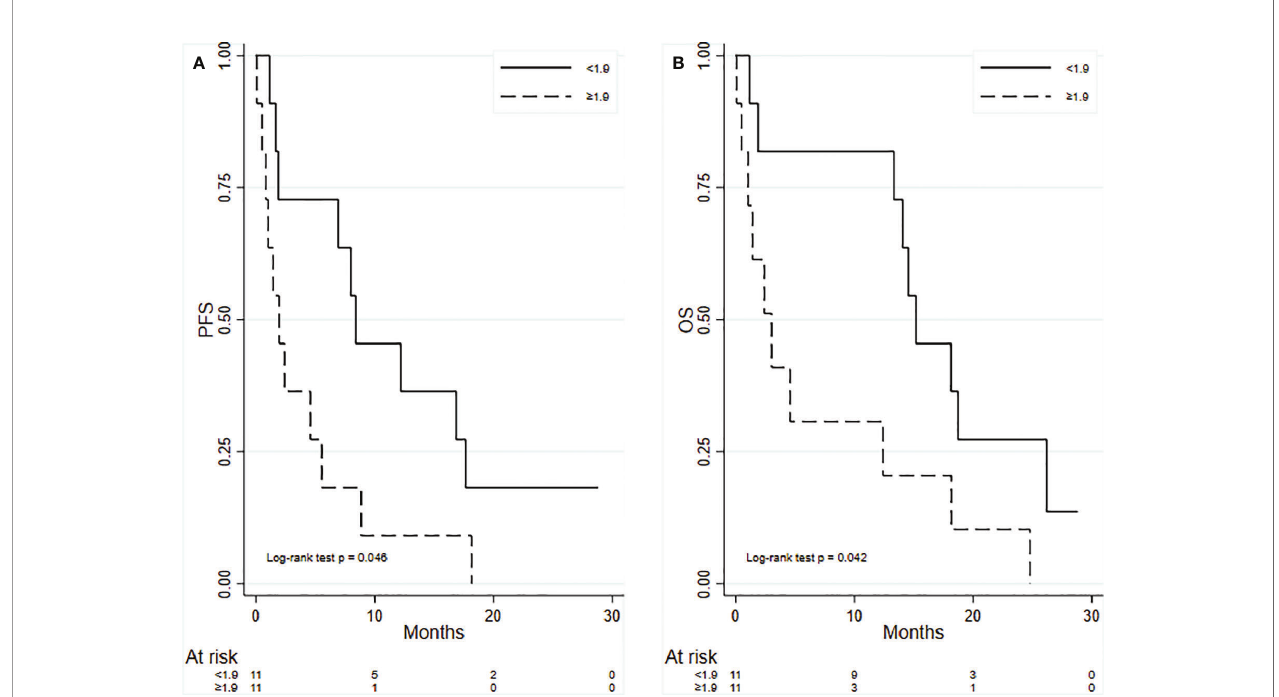
FIGURE 3 | Kaplan – Meier curves for the analysis of PFS (A) and OS (B) according to M-MDSC levels (< vs. > median value). PFS, progression-free survival; OS, overall survival; M-MDSC, monocytic myeloid-derived suppressive-like